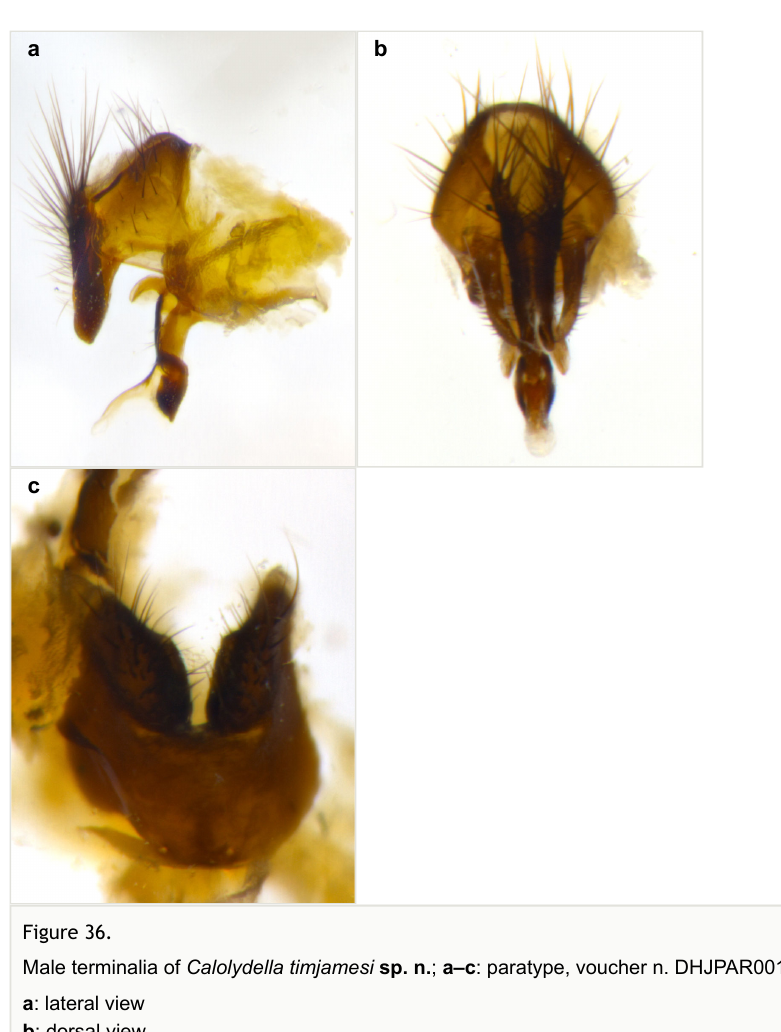
Female (Fig. 35d, e, f). Length: 4–6mm. Fronto-orbital plate 1.73X wider than in male. Diagnosis Calolydella timjamesi can be distinguished from all other species of Calolydella by the following combination of traits: fronto-orbital plate sparsely setulose to bare, frontal setae extending beyond base of postpedicel, abdominal ground color black, anatergite with three or more setae often in a small tuft, and scutellar discal setae slightly closer togetherthan subapical scutellar setae.